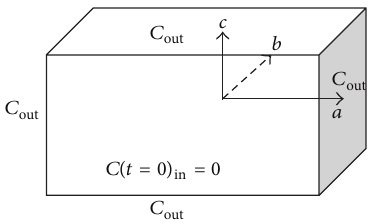
Figure 3: Shoe-box like crystal with sides 2𝑎 , 2𝑏 , and 2𝑐 . The outsidethecrystalatanytime.Inside, substrateconcentrationis 𝐶 out 𝐶 is initially zero and evolves as a function of time. in